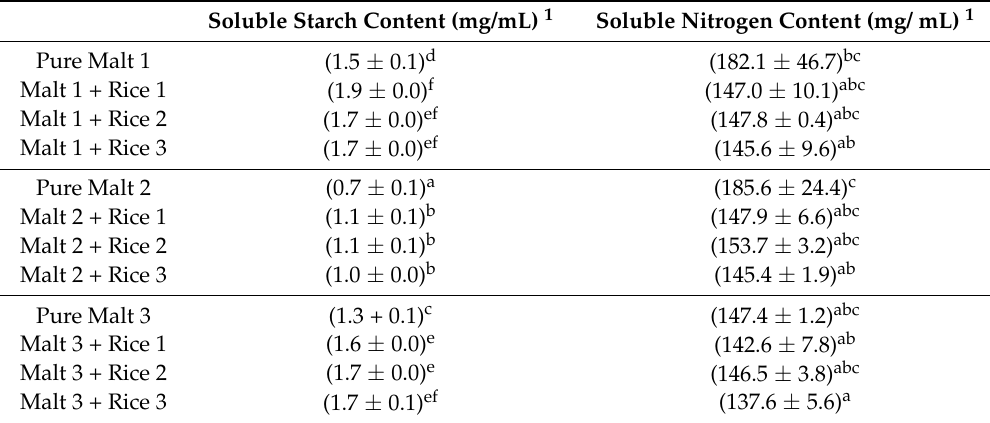
Table 3. The soluble starch and nitrogen contents in the wort samples after